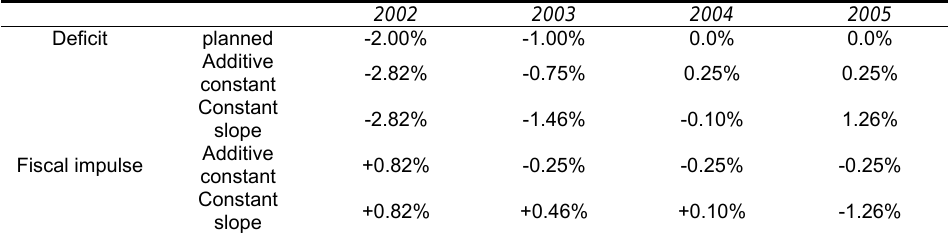
Table 12. Change in the fiscal impulse of the German in reaction to a additive constant and constant slope revision of the original SP plan to meet the debt target in 2005